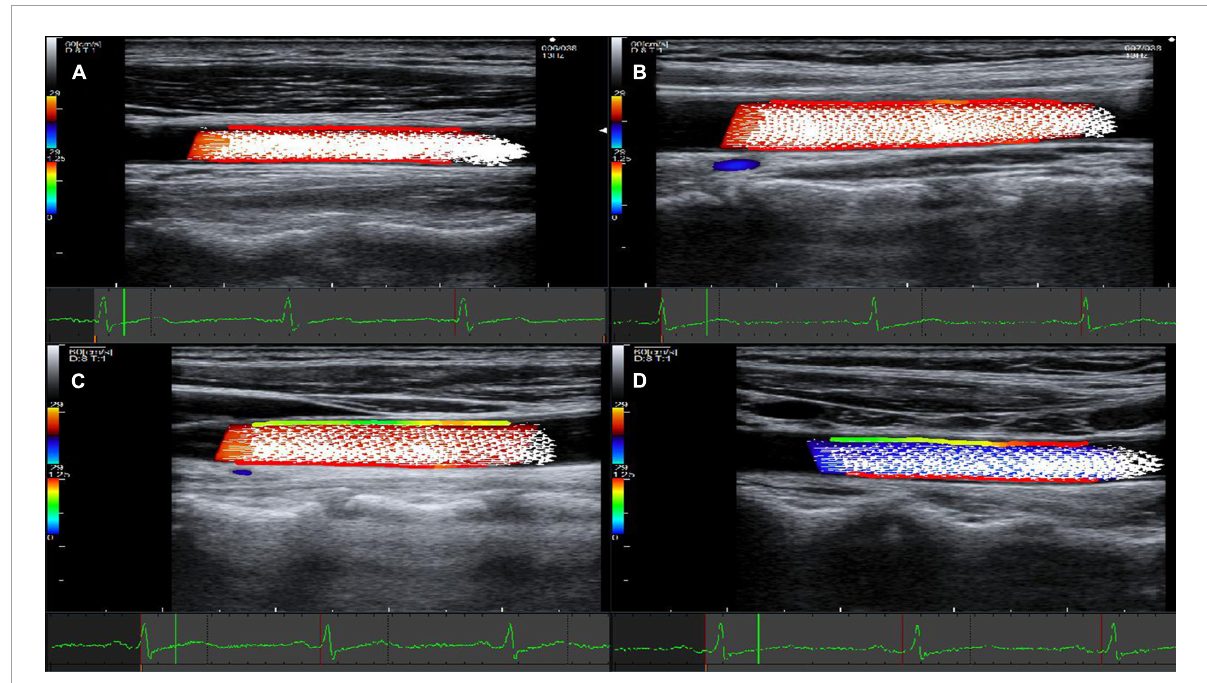
FIGURE3 Representative images acquired using vascular VFM technology. (A) Fifty-five year-old male in the CON group. (B) Sixty-three year-old female in the CON group. (C) Fifty-five year-old female in the HP group. (D) Fifty nine -Year-old male in the HP group. Frames that correspond to the systolic period of the cardiac cycle were selected for all four patients. The red lines on the blood vessel wall indicate high wall shear stress, while the green lines indicate low wall shear stress. The front and rear walls of the carotid artery show high WSS in both (A,B) , and the WSS on the anterior walls of the carotid artery was significantly lower in both (C,D)